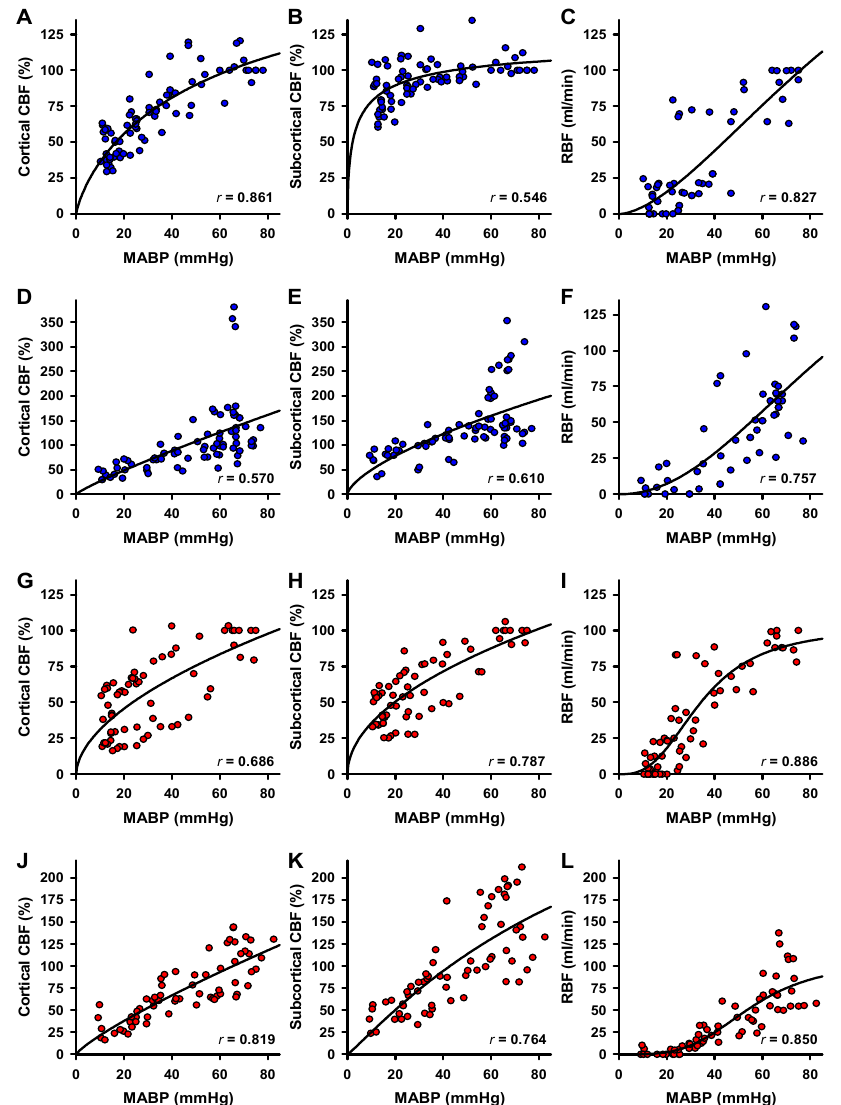
0255075100125150175200 Figure 4. Correlation of blood flow and MABP. Cortical or subcortical CBF or RBF in the control group (blue symbols) were plotted against MABP during blood withdrawal ( A – C ) and for the reperfusion phase ( D – F ), respectively. The effect of α 1A-adrenergic blockade (red symbols) on the relationships of blood flow and MABP during blood withdrawal ( G – I ) or during reperfusion ( J – L ) is plotted analogously. Three-parameter logistic regression was calculated for each data set (solid lines). Correlation coefficients ( r ) are given in the respective panels, p < 0.00001 for all data sets.